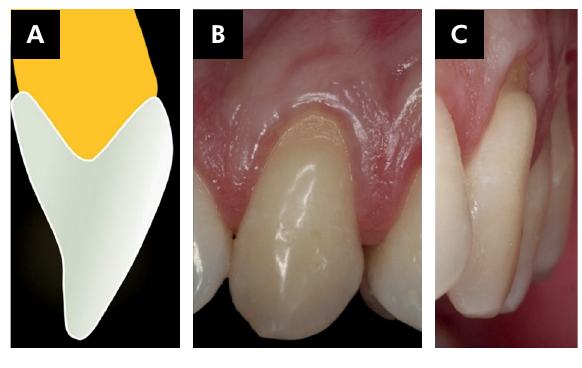
Figure 1. Schematic view of the A- tooth surface (a). The gingival recession presents with a visible cementoenamel junction and no step (the root surface presents with a shallow defect < 0.5 mm) (b and c).